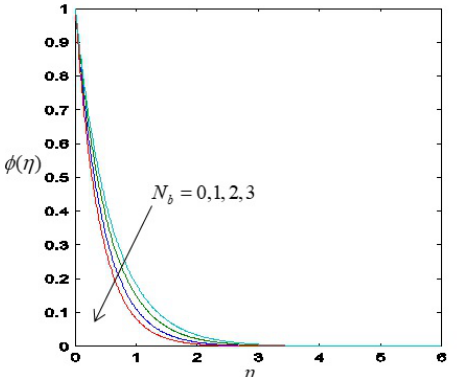
Fig. 13: Influence of Brownian motion parameter N b on ϕ ( η )